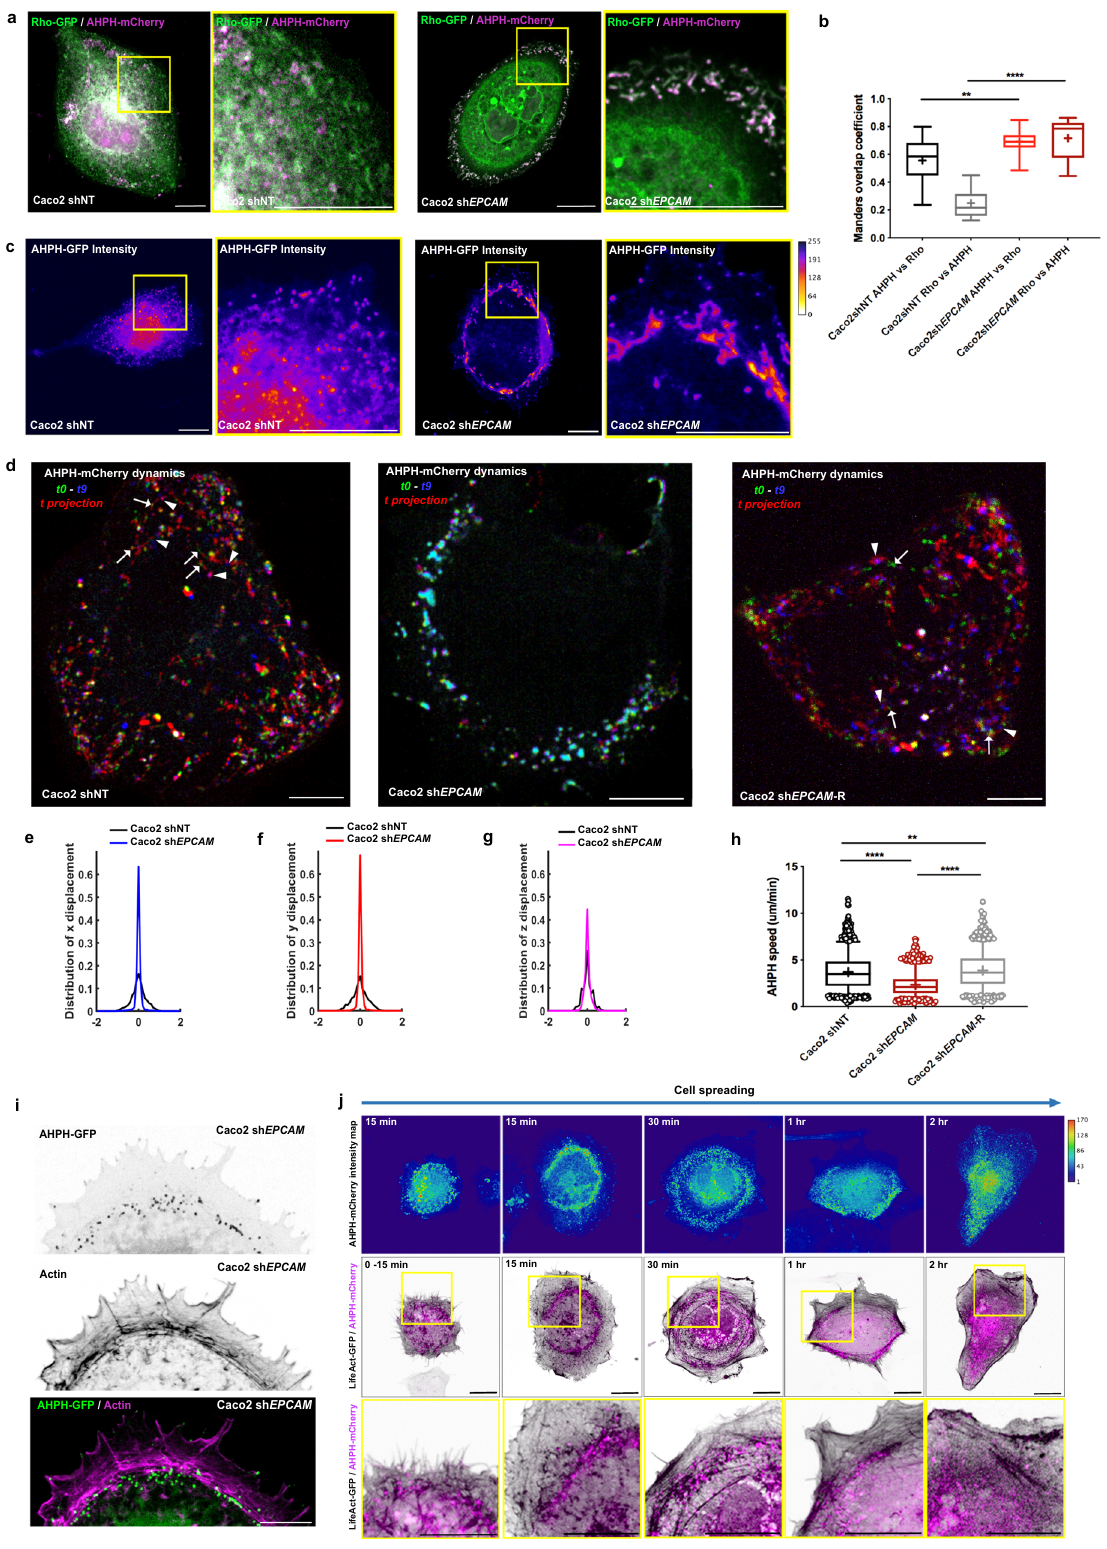
mimicking the effect of EPCAM -KD on GTP-RhoA distribution (Fig. 8g). Interestingly, concomitant perturbation of cell shape was observed after expression of EHD1G65R-GFP or Rab35S22N-GFP where mutant cells acquired an isotropic form, as EPCAM -KD cells did (Fig. 8g). However, the phenotype